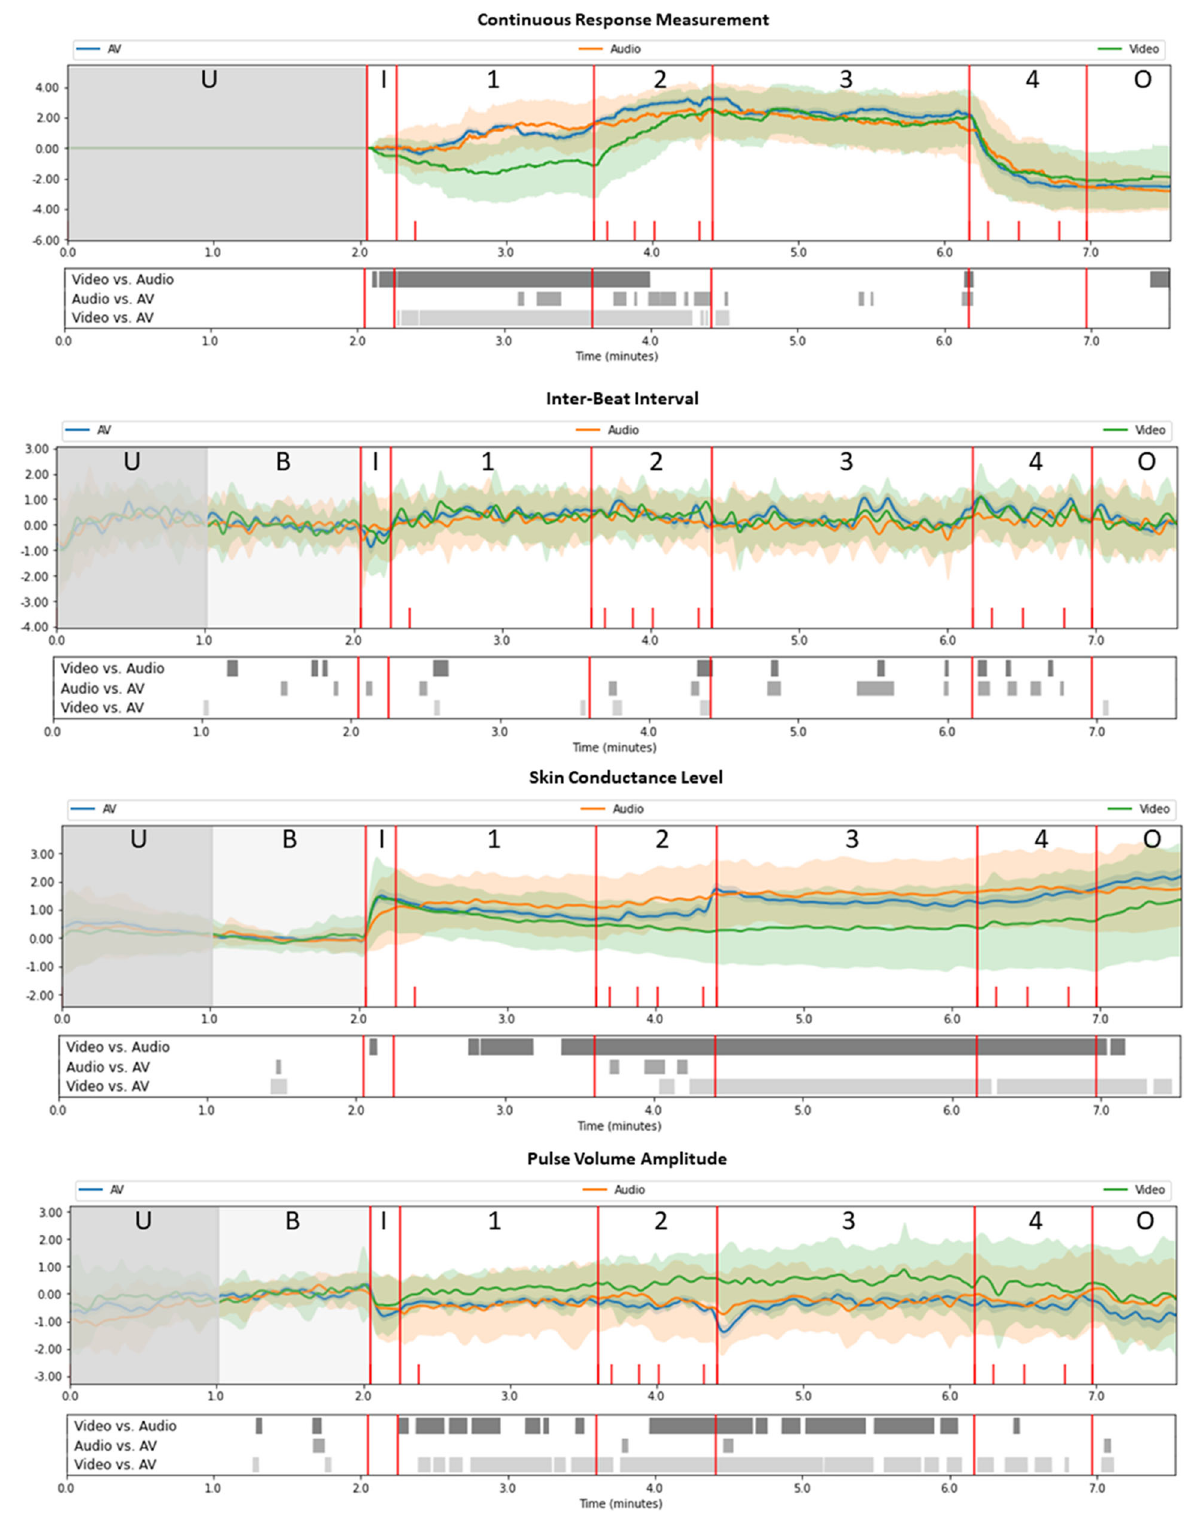
Fig. 2 Average curves and t- test comparisons of subjective and physiological audience responses under three stimulus conditions (AV: audio – visual; Audio: audio only; Video: video-only). For each dependent variable, the upper graphs show the fi ltered time series, averaged across participants with the standard error of the means as shaded areas around the mean. The vertical red lines mark the beginning and end of the major stimulus segments: U = unused; B = baseline; I = Intro; 1 = diffuse tension; 2 = story framing; 3 = anticipatory suspense; 4 = resolution/relief; O = Outro. The lower parts of each sub-graph show the results of the frame-by-frame pairwise t -test comparisons between the experimental groups ( p < 0.05, uncorrected) are marked as gray blocks).